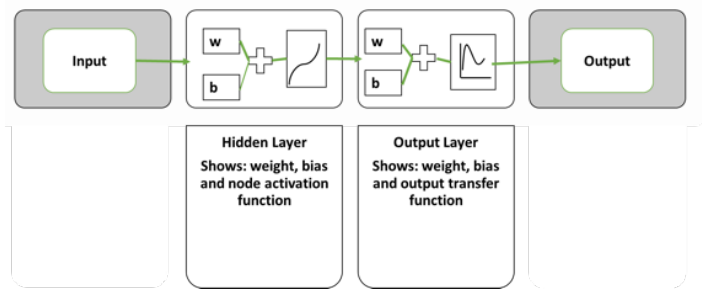
Figure 5. ANN structure showing.